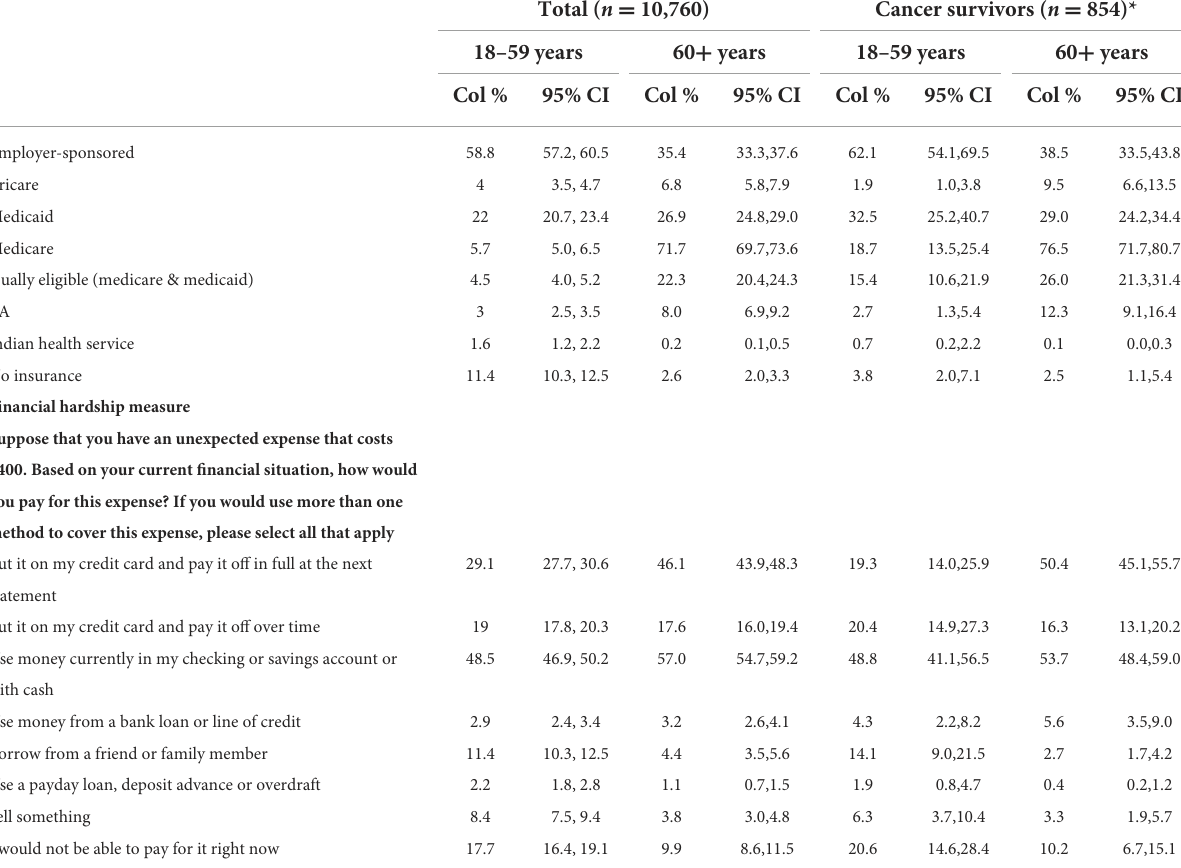
toexposuretoCOVID-19,IwasunemployedbutlookingforworksinceMarch1st,2020whenCOVID-19beganspreadingintheUS,Iwasunemployedandbeganlookingforworkafter March1,2020whenCOVID-19beganspreadingintheUS.